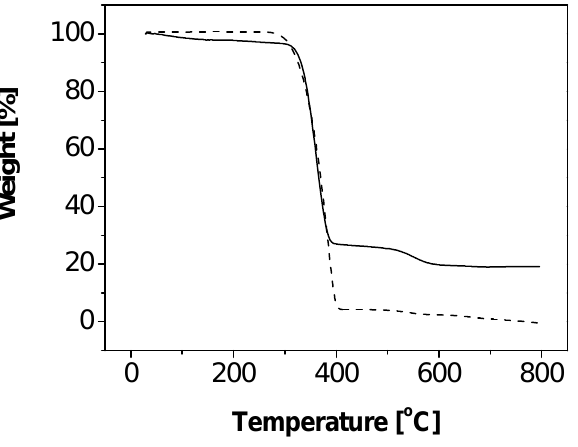
Figure 2. Thermogravimetric analysis of the nanocomposite particles prepared using VA-086 as the initiator before (solid line) and after (dashed line) HF etching